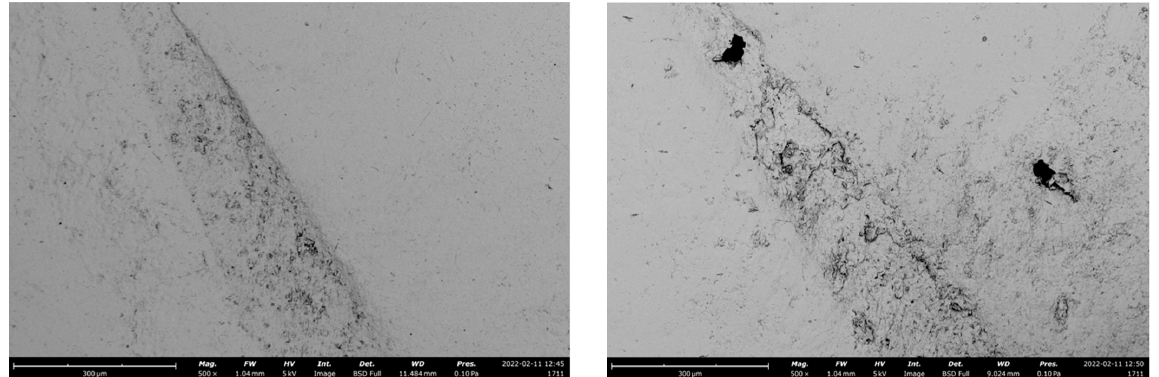
Figure 1. Representative SEM images of the adhesive interface of an adhesive crown before ( left ) and after ( right ) the chewing simulation test, restored with lithium disilicate.